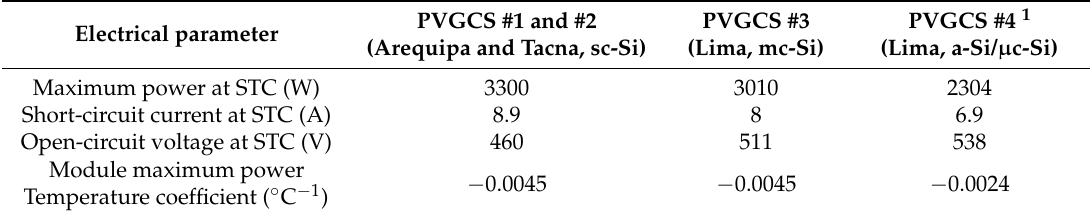
Table 2. Values of the main electrical characteristics of the PV fields of the systems under investigation according to the manufacturer’s data sheets.